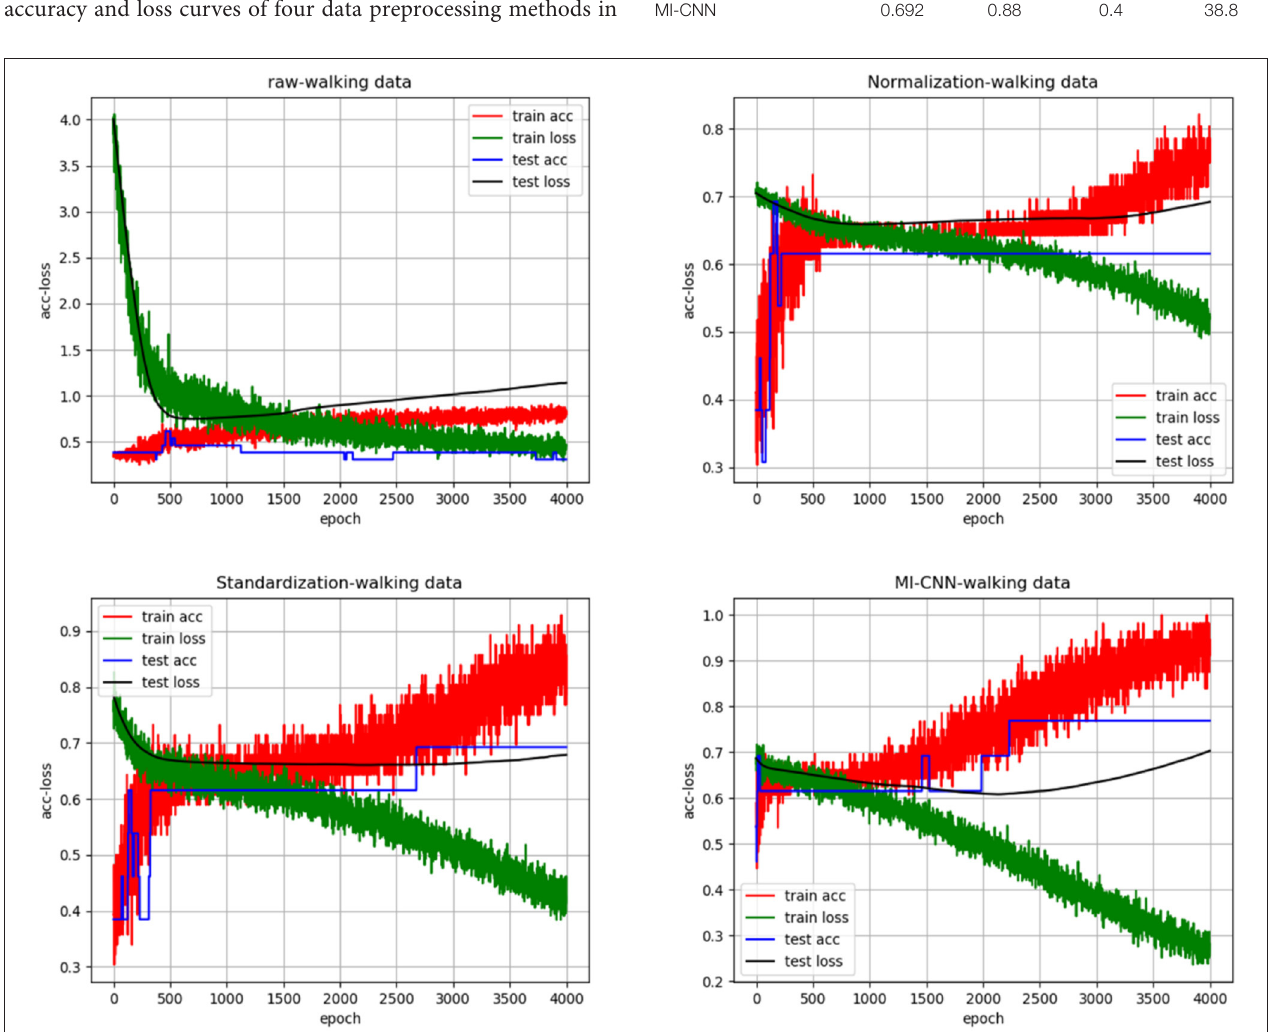
FIGURE 4 | “acc-loss” curves with different data preprocessing on the walking dataset.